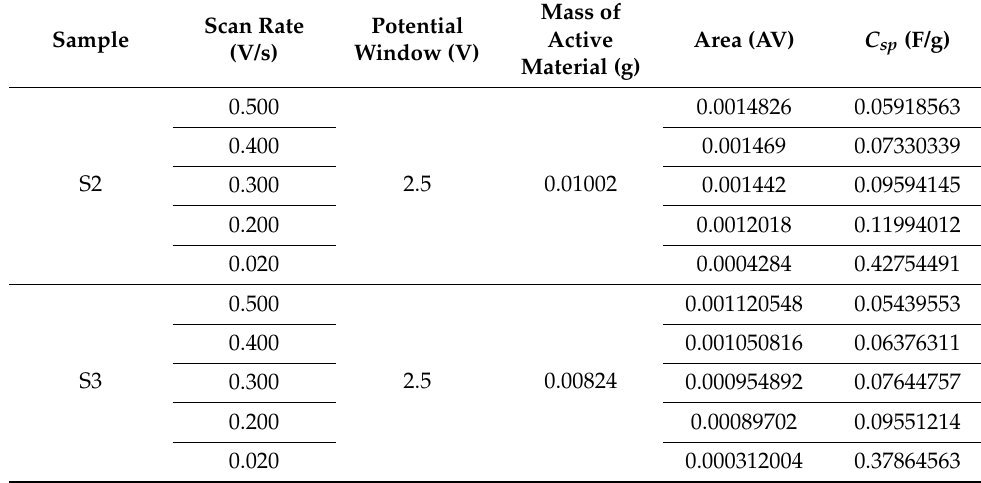
Figure 4. ( a ) CV plots of three types of electrodes (S1, S2, and S3) at 500 mV/s; ( b ) Are (AV) versus scan rate (V/s); ( c ) C sp (F/g) versus scan rate (mV/s). Table 1. C sp and area in CV plots for S2 and S3 at different scan rates.